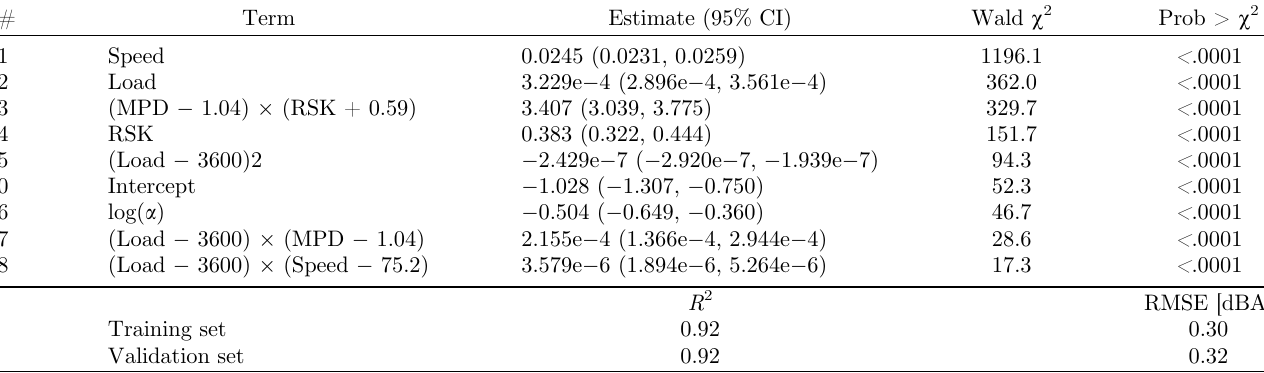
Table 4. Regression results of the winter tire. The fi rst column corresponds to the x -axis of Figure 11. # Term